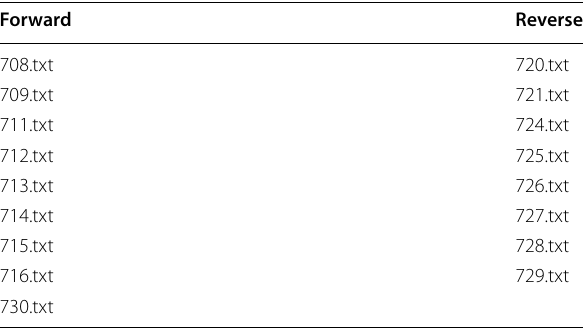
Table 2 Files used; active shot files used in the stack